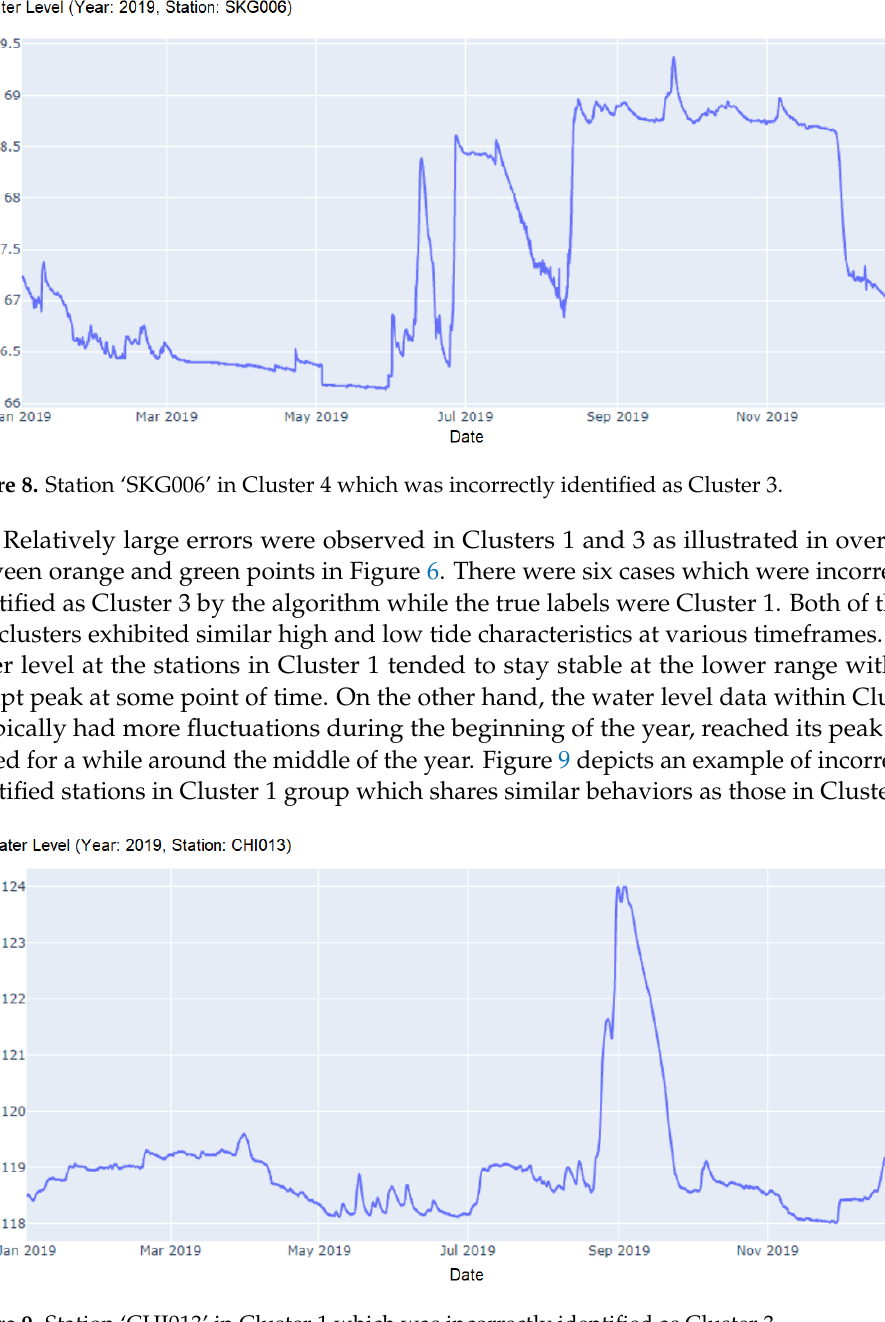
Figure 9. Station ‘CHI013’ in Cluster 1 which was incorrectly identified as Cluster